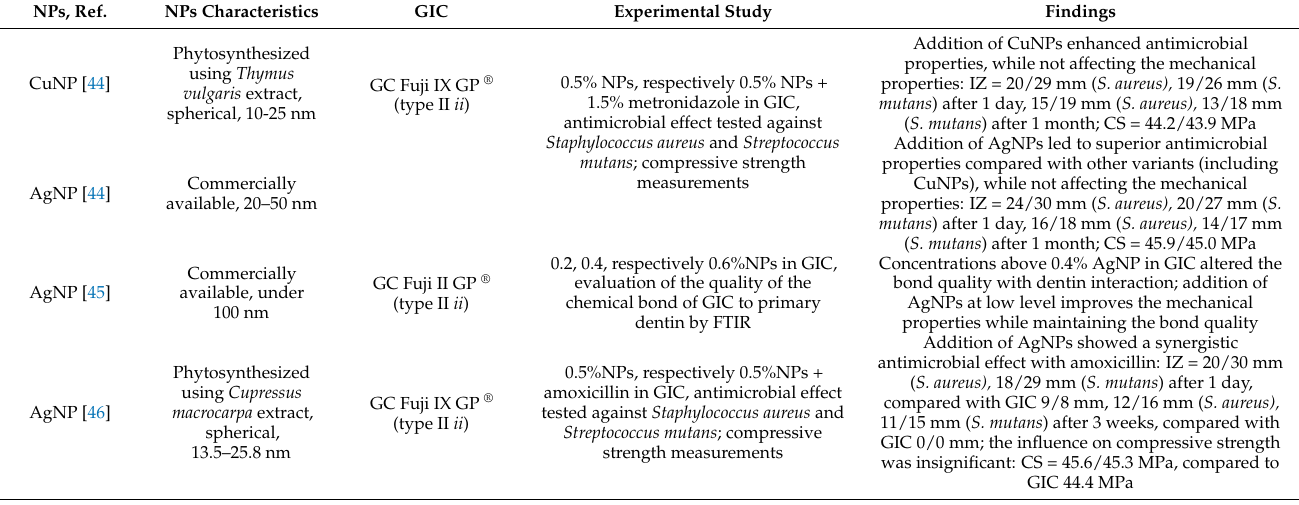
Table 3. Examples of NPs incorporation in GIC (references presented in chronological order) 1